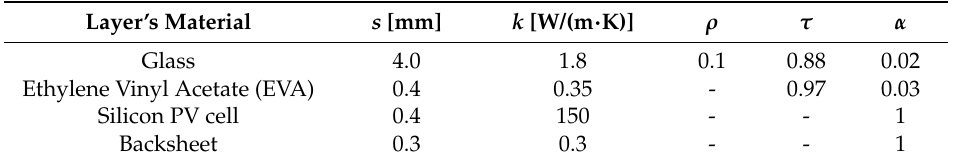
Table 1. Thickness ( s ), thermal conductivity ( k ), and optical coefficients ( ρ , τ , α ) of the PV module layers.